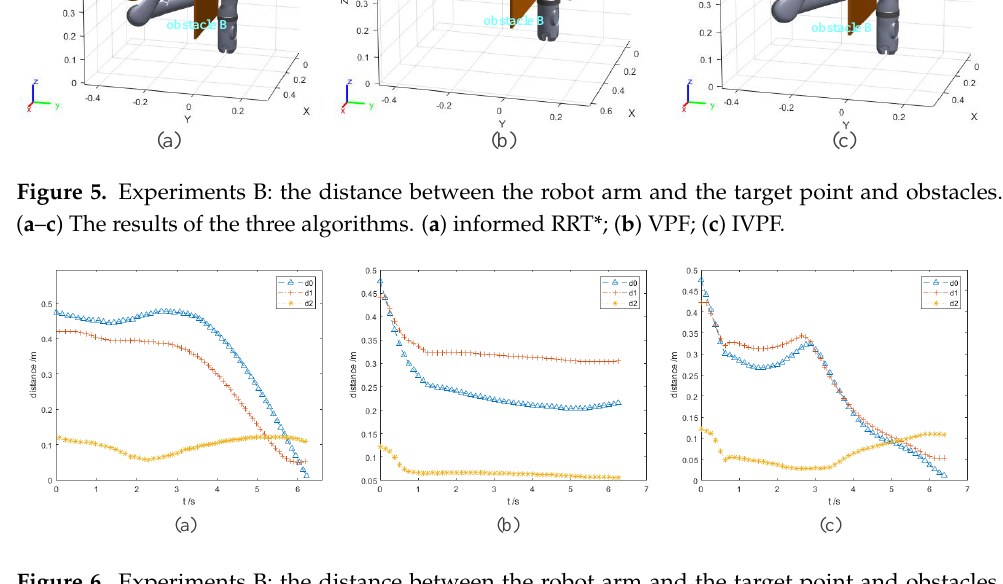
Figure 6. Experiments B: the distance between the robot arm and the target point and obstacles. ( a – c ) The results of the three algorithms. ( a ) informed RRT*; ( b ) VPF; ( c ) IVPF. Table 3. The result of static obstacles avoidance experiment II. Experiments